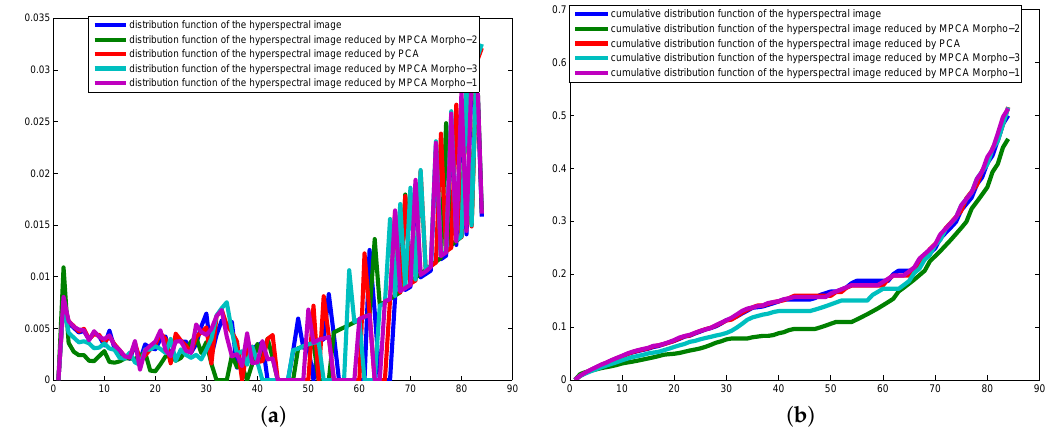
Figure 15. ( a ) 3D pattern spectrum distribution of Pavia hyperspectral image and of the different reduced images into d components; ( b ) Corresponding 3D cumulative pattern spectrum